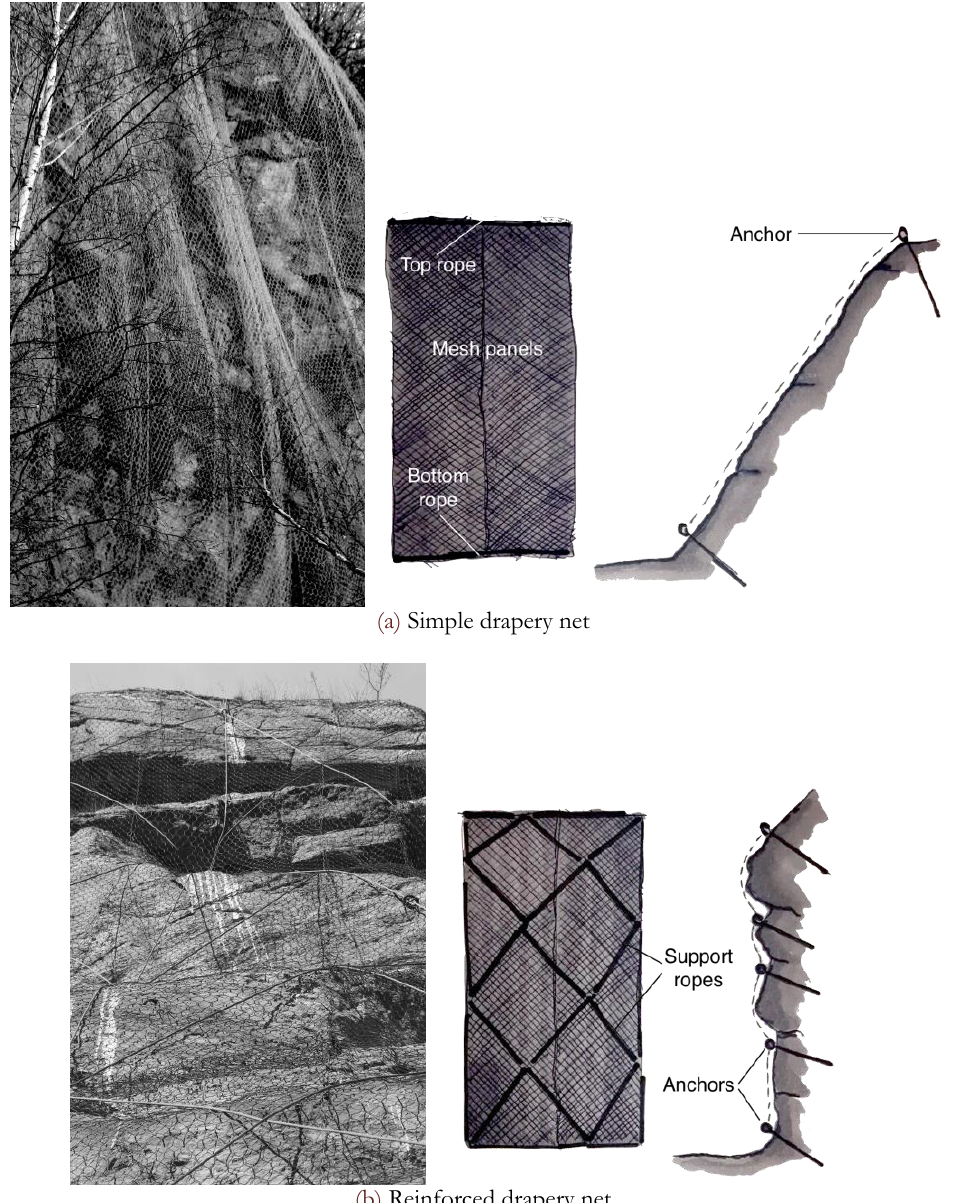
Figure 1: Views and sketches of (a) the simple drapery net and (b) the reinforced drapery net installations. Note that the reinforced drapery net follows the shape of the cliff